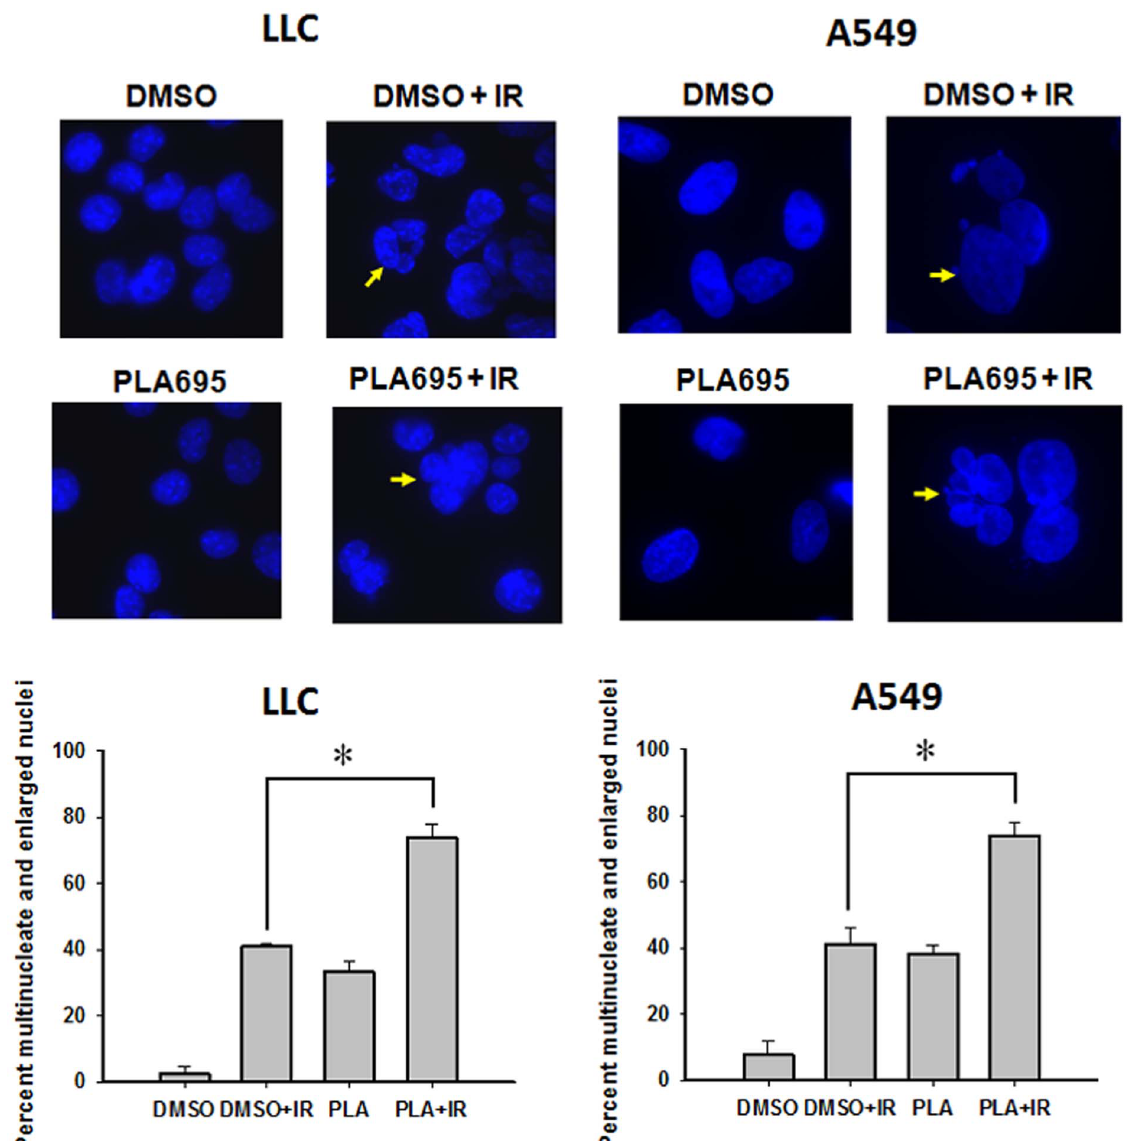
Figure 4. PLA-695 enhances cell death in irradiated lung cancer cells. LLC and A549 cells were grown in chamber slides were treated with 300 nM PLA-695 or DMSO for 45 min prior to irradiation with 3 Gy. Cells were fixed 96 h later and stained with 4 9 ,6-diamidino-2-phenyllindole (DAPI). Shown are the micrographs of DAPI stained cells, arrows indicate multinucleate cells and giant cells. Multinucleated and giant cells were counted in five randomly selected fields. A bar graph depicting the average percent of multinucleate/giant cells for each treatment is